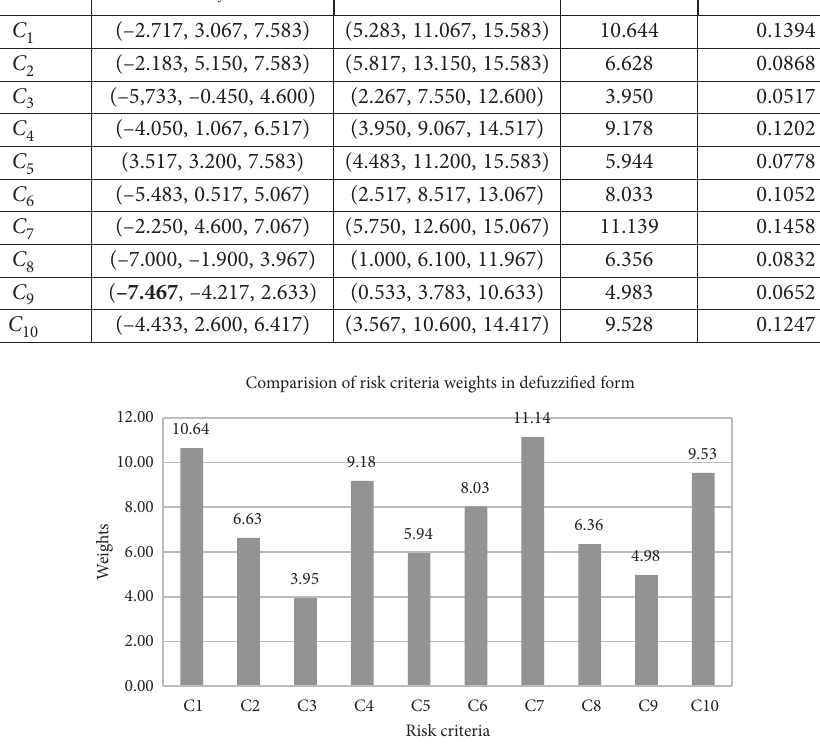
Figure 6. Ranking of ten risk criteria in Telecom sector Table 6. Linguistic variables and grey numbers for evaluating the